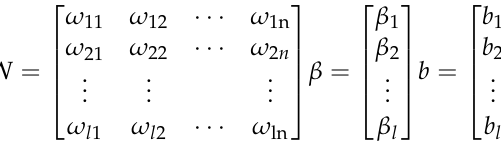
Figure 1. Schematic diagram of the GPS positioning.